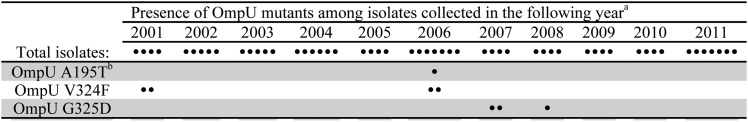
Identification of OmpU mutants in samples collected at the International Centre for Diarrheal Disease Research, Bangladesh between 2001–2011.(a) Single V. cholerae O1 El Tor isolates from different stool samples collected within a given year are indicated as closed circles. (b) The number of isolates with the noted mutation is indicated in a given year. If left blank, OmpU was wild-type.